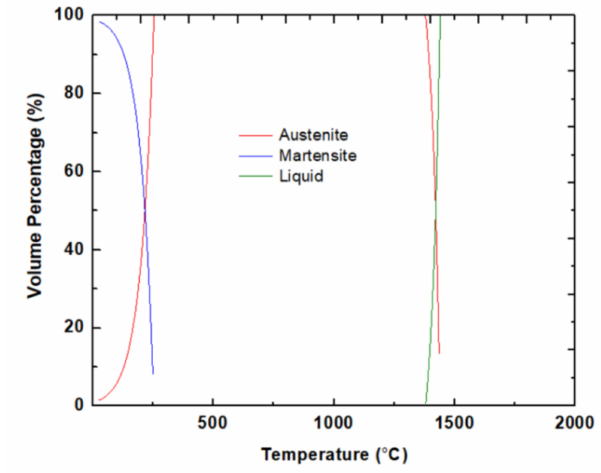
Figure 6. The expected phases of the sample during solidification at a cooling rate of 10 6 ◦ C /